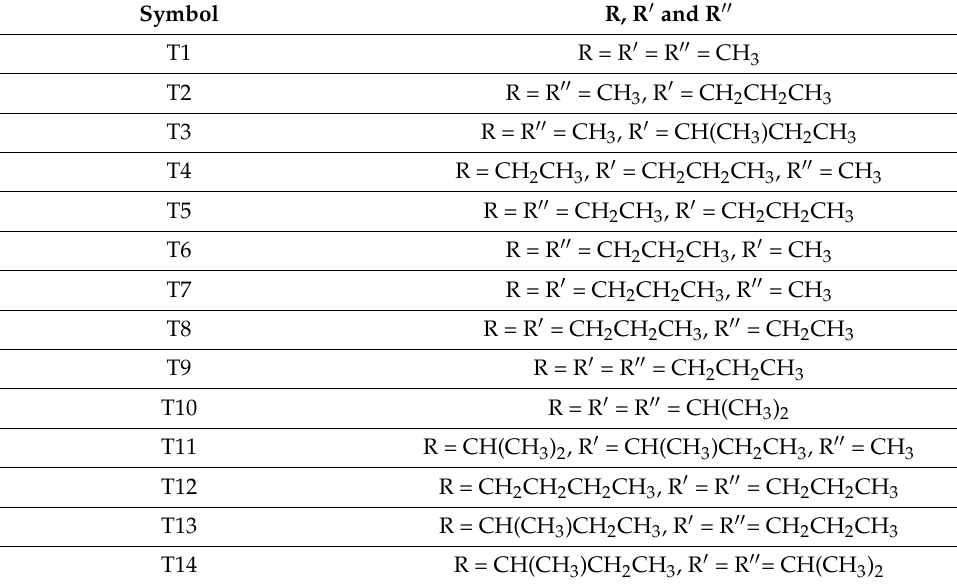
Table 1. Symbols (T followed by a number) utilised to denote the different combinations of acyl groups in the calculated trimeric acylphloroglucinols. The same symbol is used in the acronyms denoting different molecules having the same combination of acyl